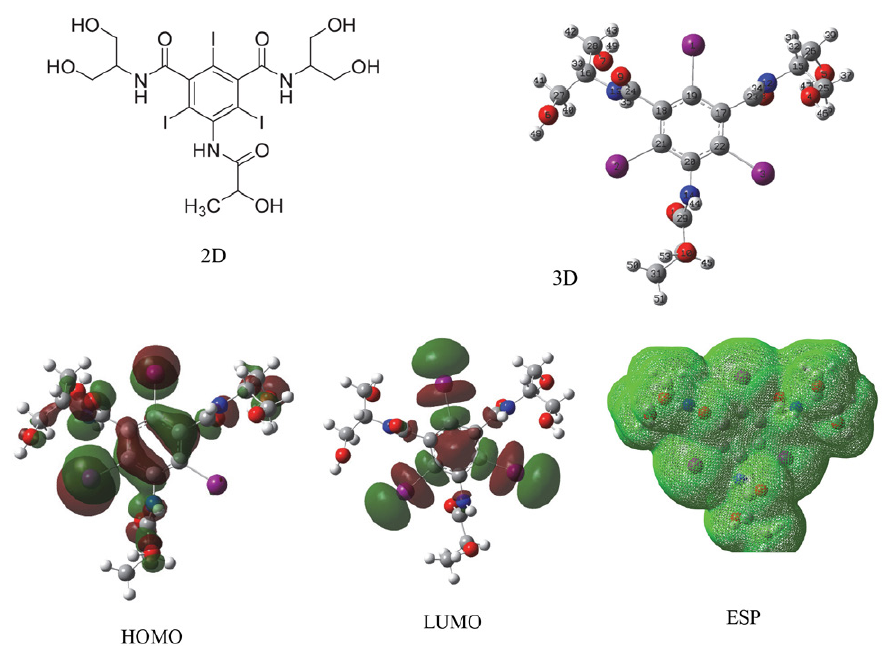
Figure 1. Optimized Structure, HOMO, LUMO and electron density of Iopamidol